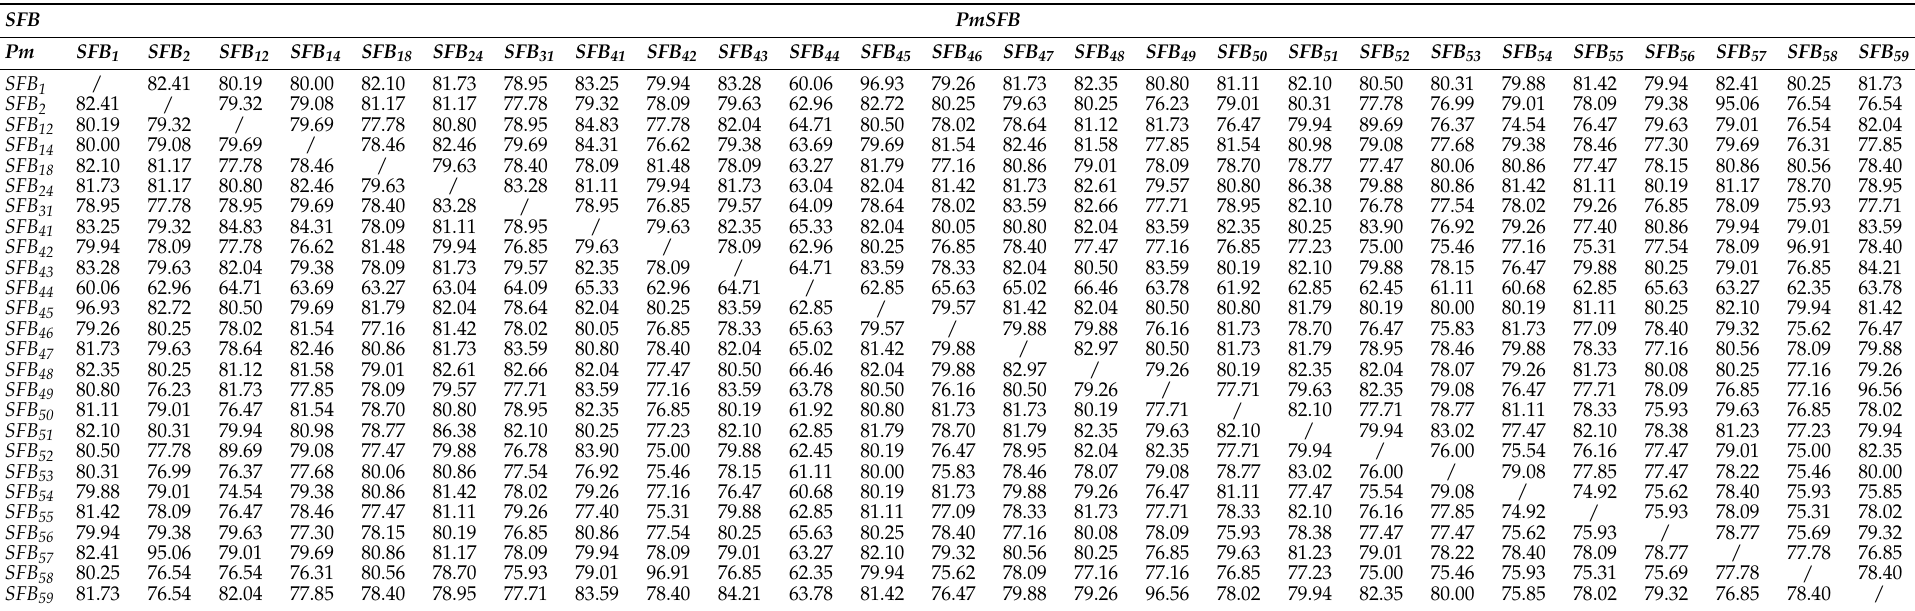
Table 2. Homologies (%) of deduced amino acid sequences of PmSFB